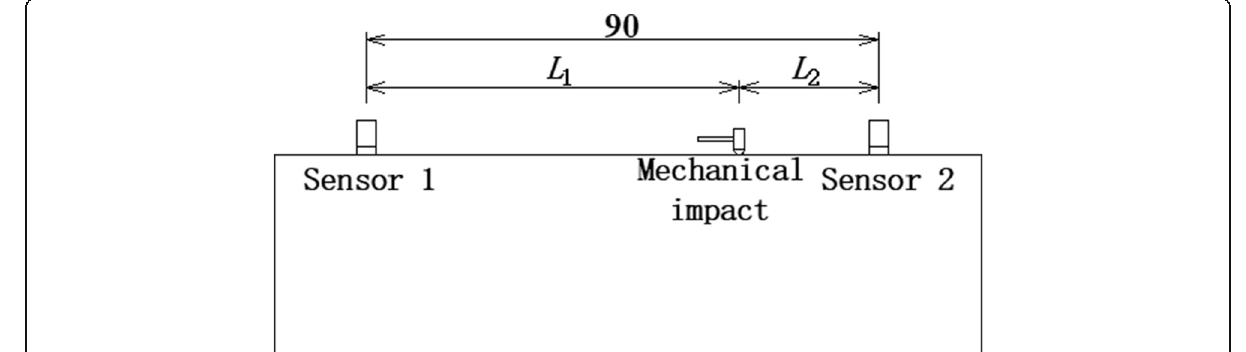
Fig. 8 Test configuration for the travel velocity of P-wave